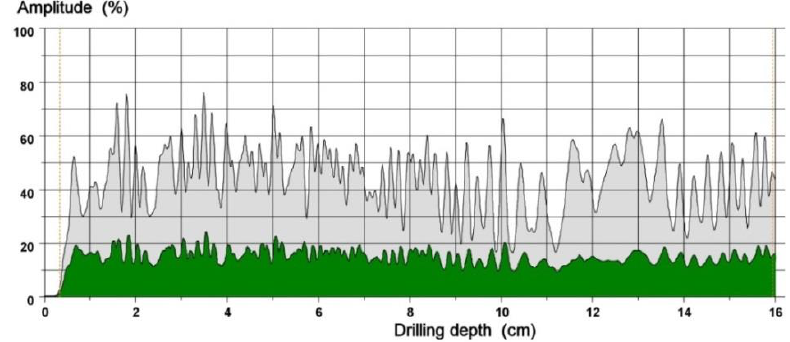
Figure 7. Exemplary drilling resistance curve (green) and feed force curve (grey). Table 6. Mean drilling resistance tests results.